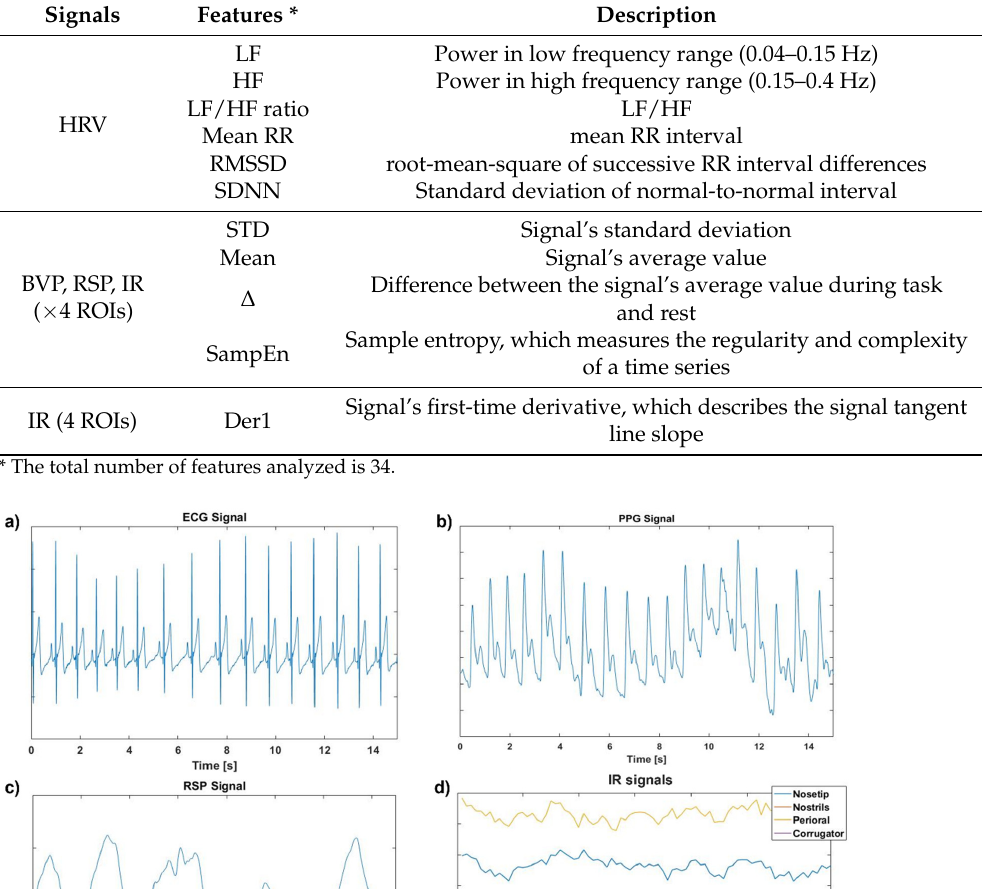
Table 2. Description of the features extracted from HRV, BVP, RSP, and IR signals. Signals